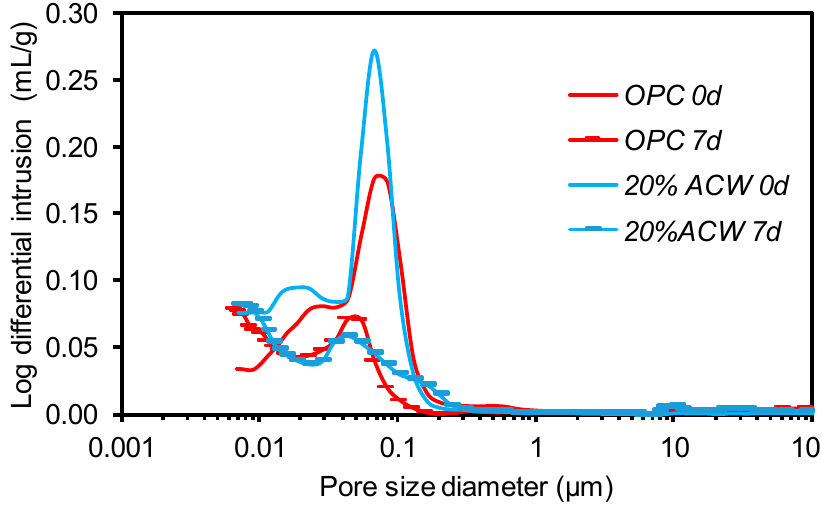
Figure 12. Density curves by exposure time.